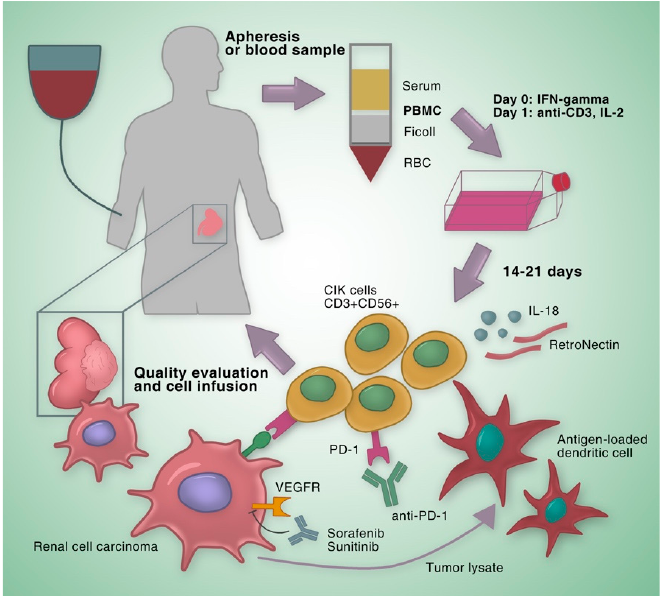
Figure 2. Strategies for improving clinical curative effects of CIK cells. PBMCs are isolated by density gradient centrifugation and expended with IFN- γ , anti-CD3 and IL-2. After 14–21 days, CIK cells are infused into the patient. The anti-tumor activity of CIK cells can be enhanced by adding cytokines like IL-18 or RetroNectin during expansion. DCs have high ability to present tumor antigens and compensate the lack of tumor antigen specificity of CIK cells. Targeted agents such as sunitinib and sorafenib or immune checkpoint inhibitor anti-PD-1 antibodies also have a synergistic effect with CIK cells. CIK cell, cytokine-induced killer cell; PBMC, peripheral blood mononuclear cell; IFN- γ , interferon- γ ; IL-2, interleukin-2; IL-18, interleukin-18; VEGFR, vascular endothelial growth factor receptor; PD-1, programmed cell death-1; DC, dendritic cell; RBC, red blood cell.